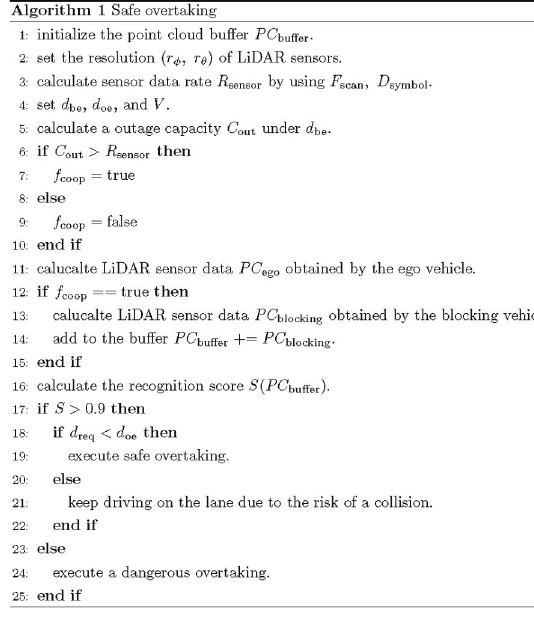
( a ) Block diagram of safe overtaking. ( b ) Algorithm of safe overtaking. Figure 17. Description of the whole process in the simulation.